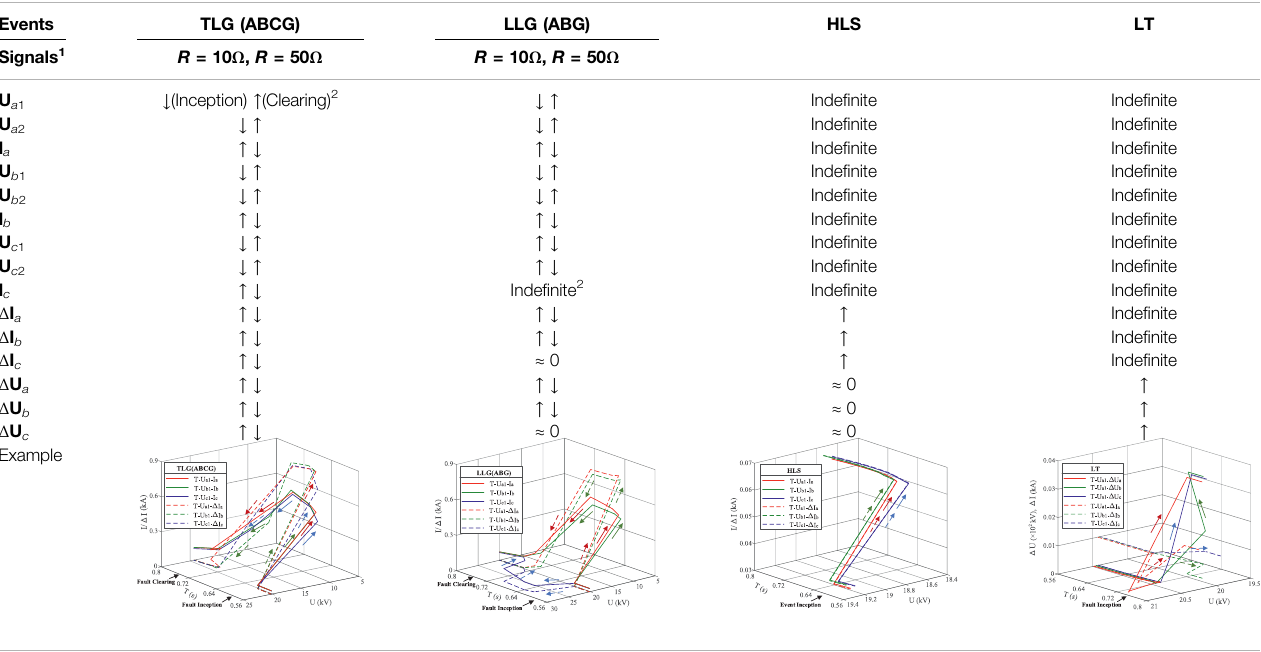
TABLE 1 | Characteristics of measurements in different events.